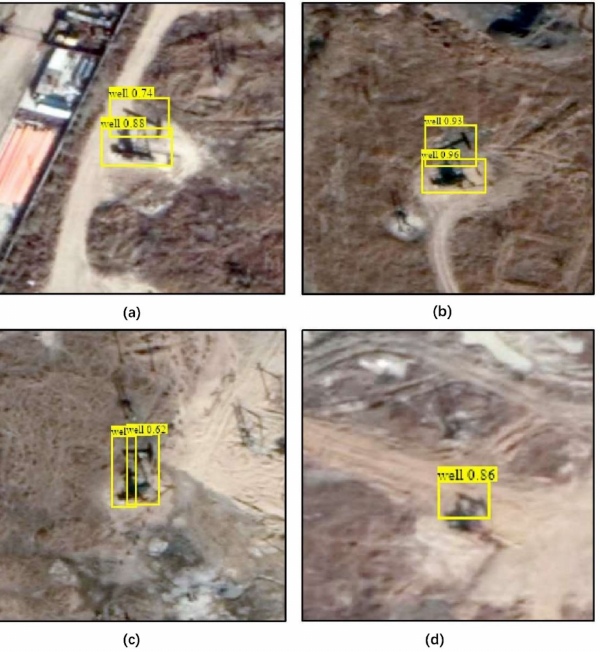
Figure 10. Oil wells on tangent lines are segmented into different slices, which causes repeated detection ( a – c ) and inaccurate positioning ( d